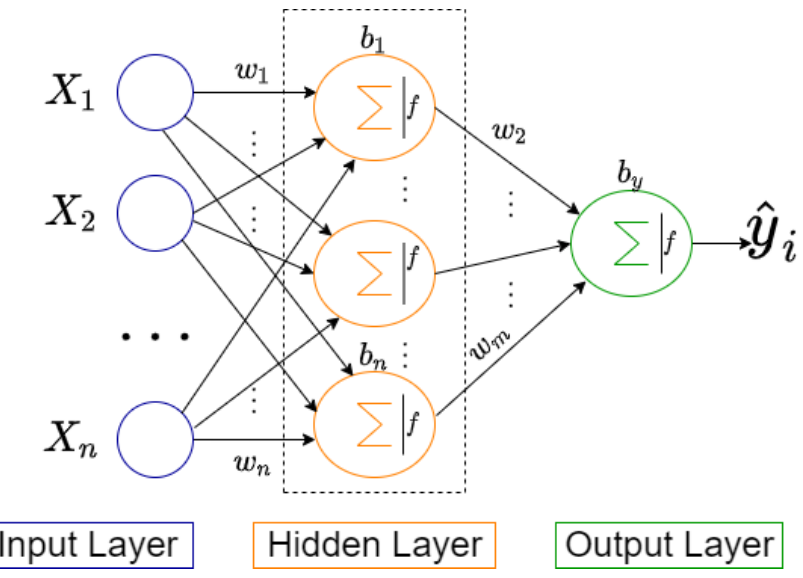
Figure 4. Architecture of a typical three-layer MLP neural